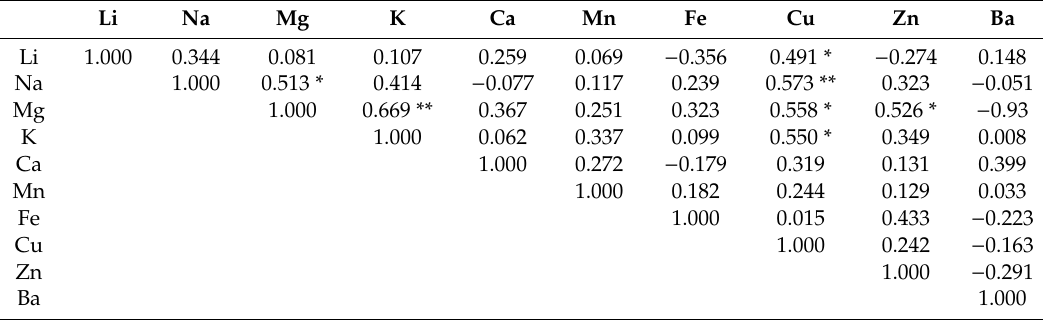
Table 5. Correlation between mineral elements in saliva of healthy controls.